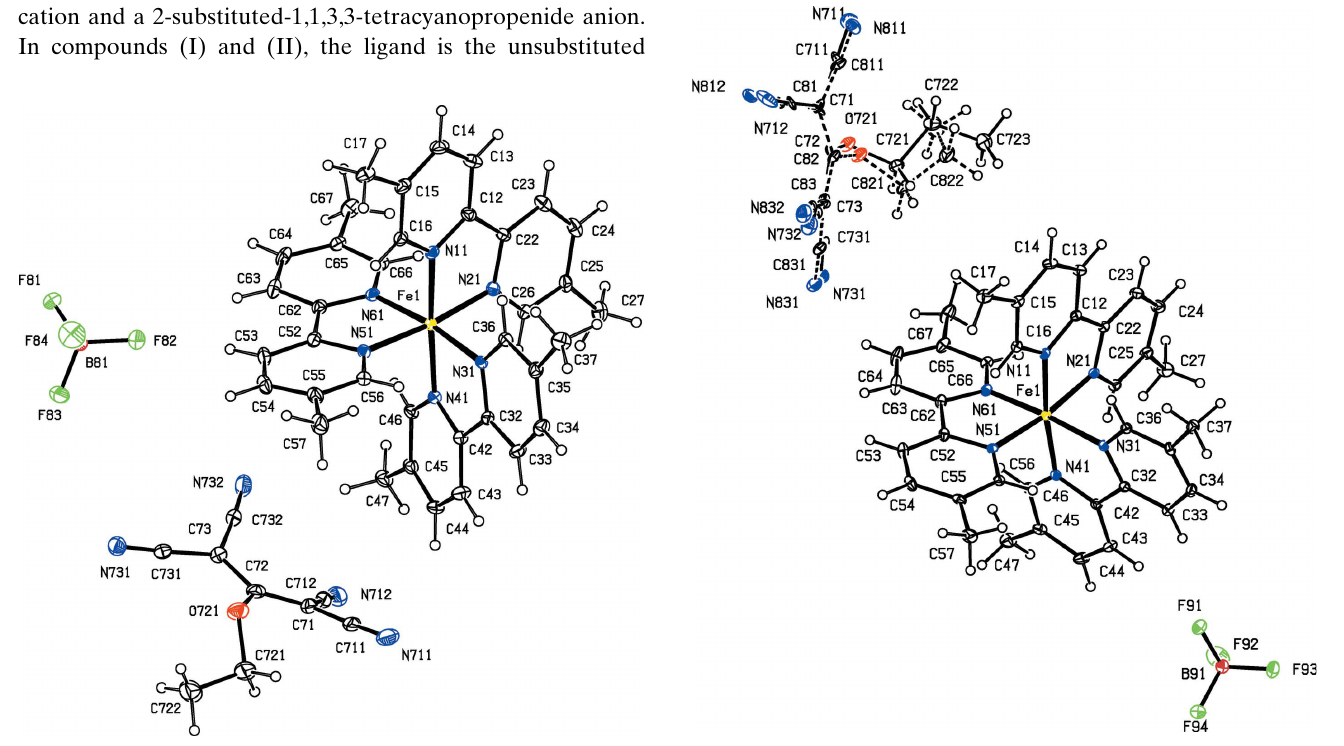
Figure 4 The independent ionic components in compound (IV), showing the atom- labelling scheme. Displacement ellipsoids are drawn at the 30% probability level.